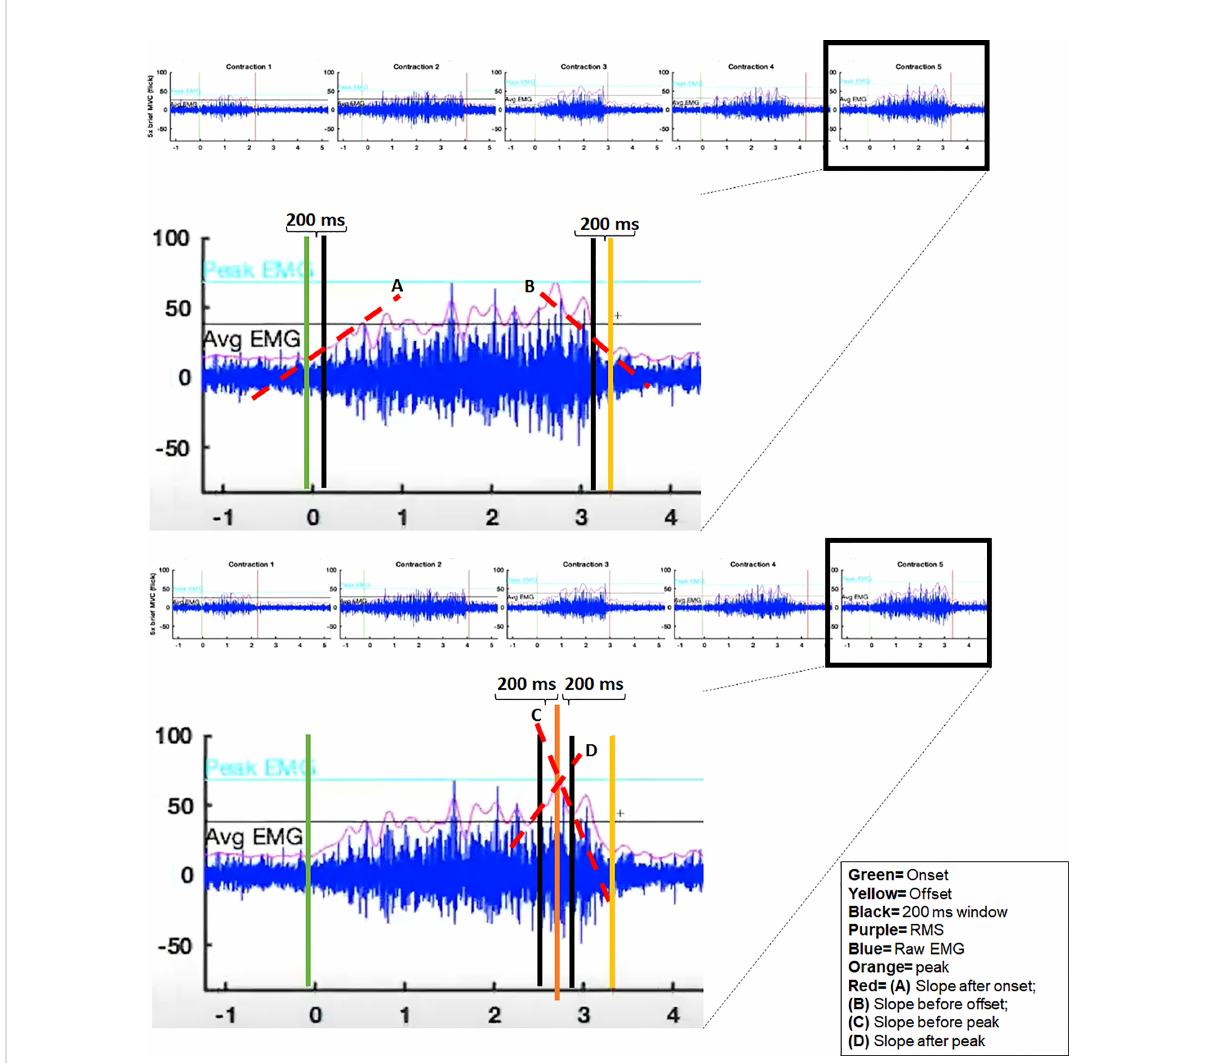
FIGURE 2 Example EMG recording of the Flick task from a representative subject, illustrating the EMG variables used in the